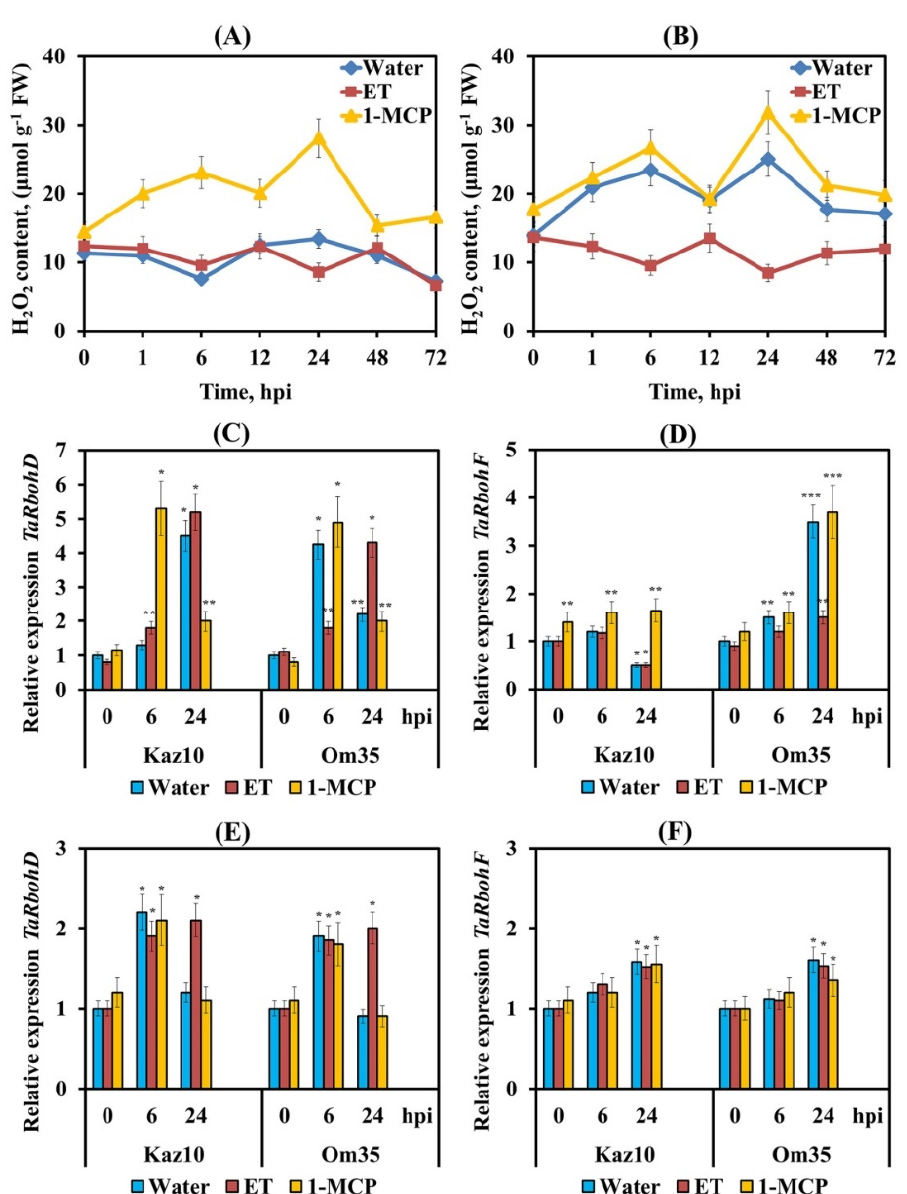
Figure 3. The effect of pretreatment with ethephone (ET) and 1-MCP on the H 2 O 2 production and relative expression of genes encoding isozymes of NADPH oxidase in Kaz10 and Om35 wheat cultivars infected with virulent SnB and avirulent Sn4VD S. nodorum isolates. ( A ) H 2 O 2 production in Kaz10 infected with SnB in the dynamics of the infectious process. ( B ) H 2 O 2 production in the Om35 infected with SnB in the dynamics of the infectious process. ( C ) The mRNA abundance of the TaRbohD in Kaz10 and Om35 infected with SnB. ( D ) The mRNA abundance of the TaRbohF gene in Kaz10 and Om35 infected with SnB. ( E ) The mRNA abundance of the TaRbohD gene in the Kaz10 and Om35 infected with Sn4VD. ( F ) The mRNA abundance of the TaRbohF gene in the Kaz10 and Om35 infected with Sn4VD. Expression values were normalized to the housekeeping gene TaRLI as an internal reference and expressed relative to the normalized expression levels in mock-treated control (Water) plants at 0 hpi. Symbols are the same as in Figure 2. Figures present means ± SE (n = 6). Asterisks indicate means statistically different from the control and different number of asterisks (*, **, ***) allows distinguishing of significantly different variants according to the LSD test at * p < 0.05, ** p < 0.01, *** p < 0.001.